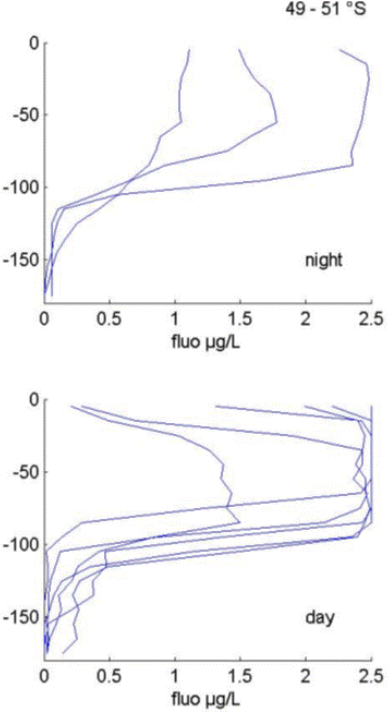
Figure 6. Example of unquenched night fluorescence profiles (top) and quenched day ones (bottom) collected on the same location and same period by a CTD-FLUO-SRDL deployed on a male SES for- aging over the Kerguelen plateau.